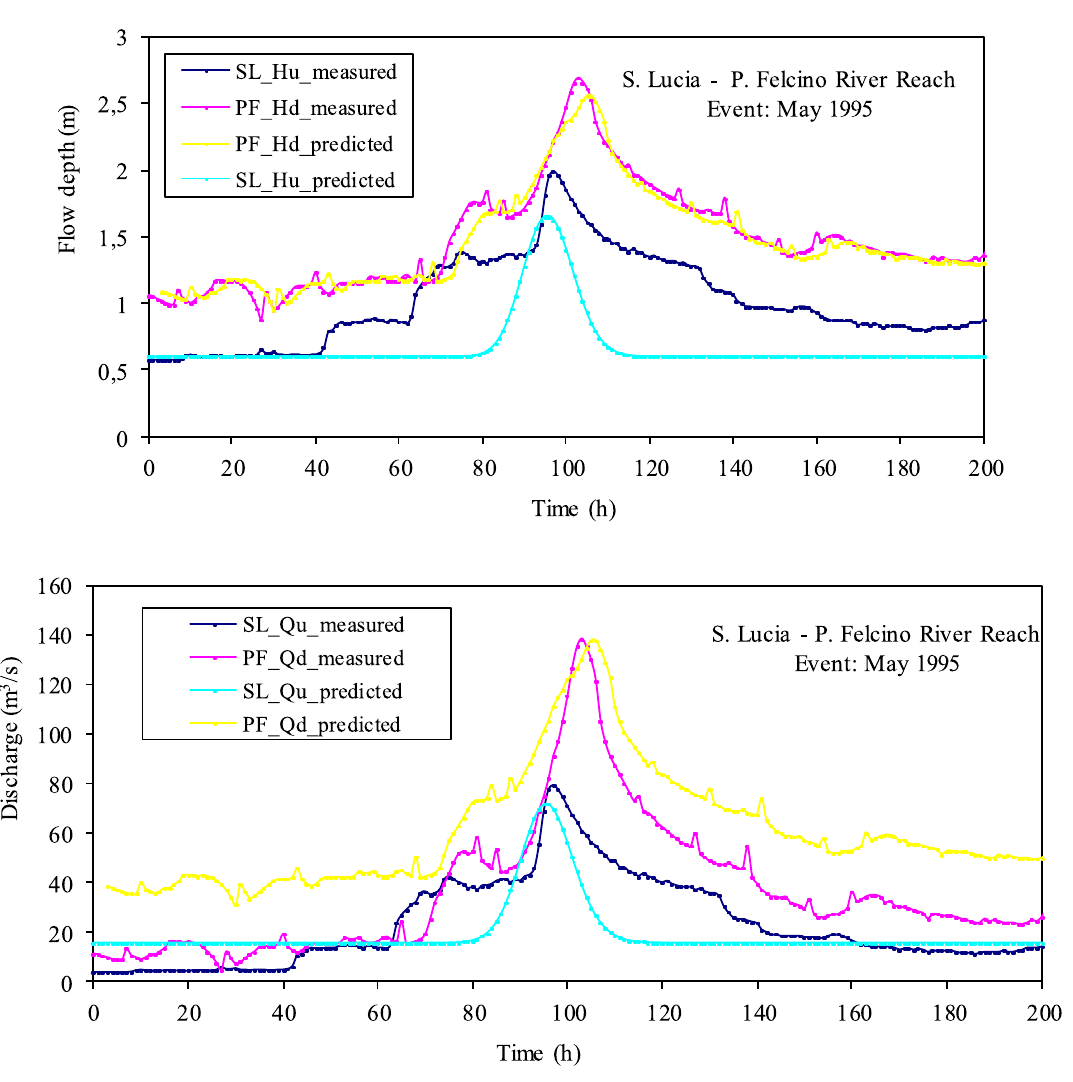
Fig. 2 Flow stage (above) and flow discharge (below) hydrograph simulations for event May 1995 in S. Lucia and P. Felcino river